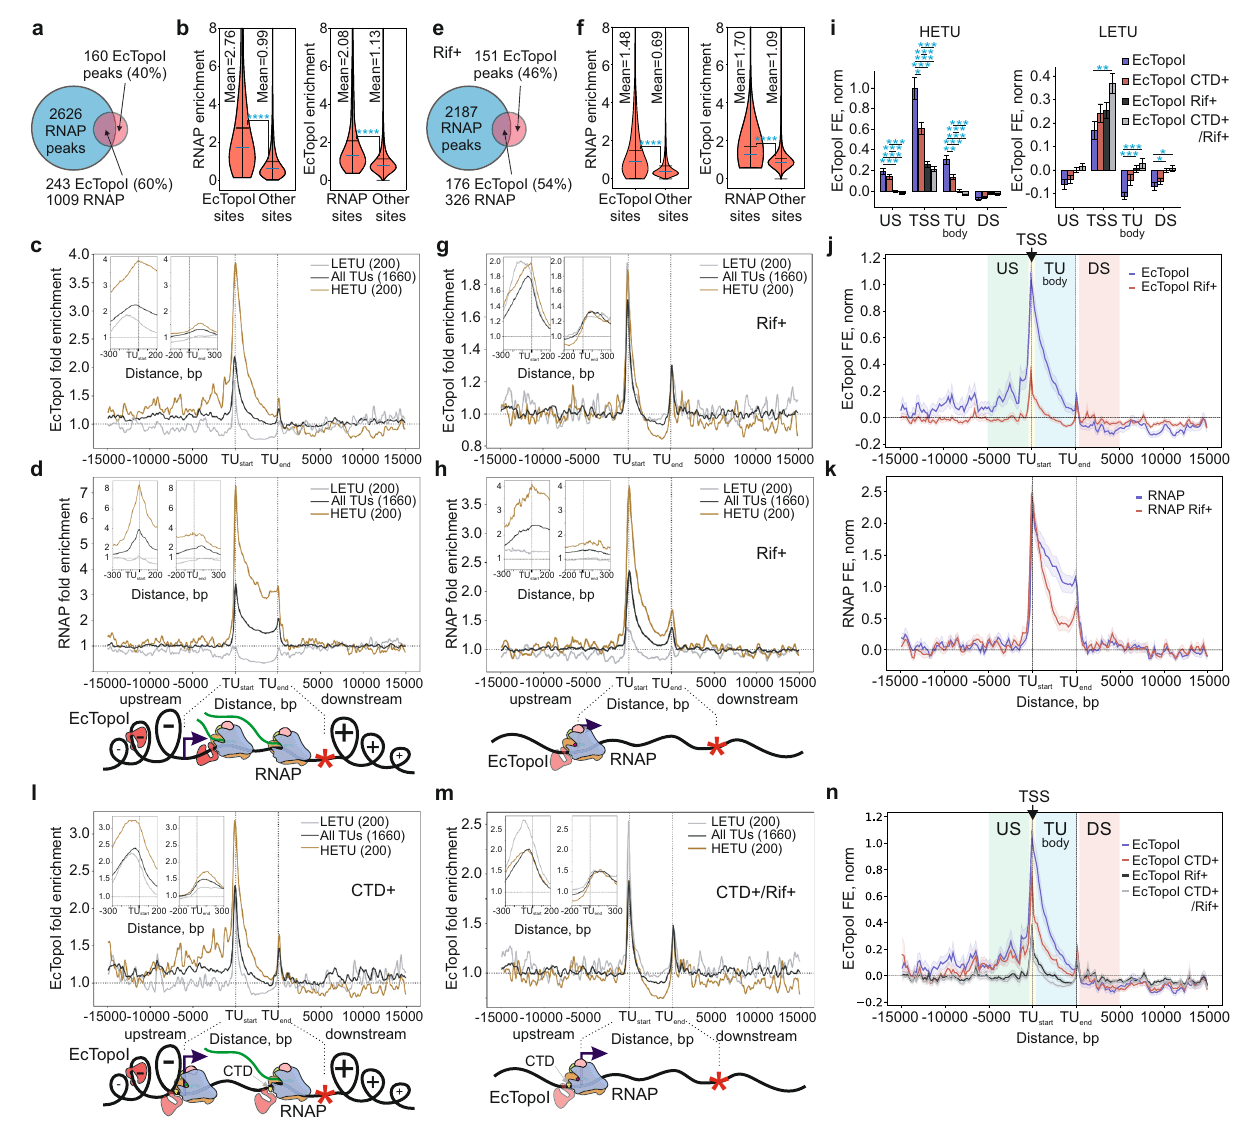
Fig. 2 | EcTopoIis associatedwithRNAP and withregions ofexpectedtranscription-inducednegative supercoiling.a Venn diagram representsanoverlapbetween the EcTopoI and RNAP peaks. b Violin plots of RNAP enrichment in EcTopoI peaks and outer regions (left), and EcTopoI enrichment in RNAP peaks and outer regions (right).Themeansandmediansareindicatedbyblackandbluelines,respectively.Statisticallysigni fi cantdifferencesbetweenmeans(two-sided t -test, p value=8e-28and 9e-123forRNAPandEcTopoIenrichments,respectively)areindicatedbyasterisks. c MetageneplotofEcTopoIenrichmentwithinTUs(middle),theirupstream(left),and downstream (right) regions. Enrichment is shown for all TUs (black curve), highly-expressed (HETU, orange curve), and least-expressed (LETU, gray curve) sets. The numberofTUsineachgroupisindicatedinparentheses.Thetwoinsetsshowzoom-inviewsofEcTopoIenrichmentneartranscriptionstart(TUstart)andtermination(TU end) sites. d Top, metagene plot of RNAP enrichment. Analysis and sets of TUs are the same as in c . Bottom, graphical representation of the Liu & Wang twin-domain model 36 showing localization of RNAP and EcTopoI according to the metagene plots in c , d . e Venn diagram represents anoverlapbetween the EcTopoIand RNAPpeaks (327 and 2513 peaks, respectively) in cells pretreated with Rif. f Violin plots of RNAP enrichment in EcTopoI peaks and outer regions (left), and of EcTopoI enrichment in RNAP peaks and outer regions (right) for Rif-treatedcells(an RpoC ChIP-chip datasetfrom ref.44). Means werecompared bytwo-sided t -test. P values9e-17and 2e-6 for RNAP and EcTopoI enrichments, respectively, are indicated by asterisks. g Metagene plot of EcTopoI enrichment for cells pretreated with Rif. h Top, metagene plot of RNAP enrichment for cells pretreated with Rif. Bottom, graphical representation showing localization RNAP and EcTopoI according to metagene plots in g , h . i EcTopoI enrichment for HETUs (left) and LETUs (right) in untreated cells (blue bars), cells pretreated with Rif (black bars), and cells overexpressing 14kDa CTD without Rif (red bars) or followed by Rif treatment (gray bars). Enrichment was quanti fi ed for normalized tracks in regions near the transcription start sites (TSS,±200bp from transcriptionstartsite),5kbupstreamregions(US),5kbdownstreamregions(DS),andTUbodies(TU).Enrichmentswerecomparedbyatwo-sidedWelch t -test. P values <2e-3areindicatedbyasteriskswiththenumberof asterisksindicating thesigni fi cancelevel,Bonferronicorrectionformultiple testingwasapplied.Barsrepresentmean values±SEM, n =200TUsforallconditions. j MetageneplotofnormalizedEcTopoIenrichmentforHETUsincellsuntreated(bluecurve)orpretreatedwithRif(redcurve). k Metagene plot of normalized RNAP enrichment forHETUs in cells untreated(blue curve) orpretreated with Rif(red curve). l Metagene plot of EcTopoI enrichment for cellsoverexpressing14kDaCTD(top)andagraphicalrepresentationofthelocalizationofRNAPandEcTopoI(bottom). m MetageneplotofEcTopoIenrichmentforcells overexpressing 14kDa CTD followed by Rif treatment (top) and a graphical representation of the localization of RNAP and EcTopoI (bottom). n Metagene plot of normalizedEcTopoIenrichmentforHETUsincellsuntreated(bluecurve),ortreatedwithRif(blackcurve),andincellsoverexpressing14kDaCTDwithoutRif(redcurve), orfollowedbyRiftreatment(graycurve).Con fi dencebands(±SEM)inpanels j , k ,and n arerepresentedbylight-coloredpro fi les.Coloredareasinpanels j and n indicate regions used to quantify enrichment in panel i (US, TSS, TU body, and DS). For ChIP-Seq, fold enrichment is given relative to the input